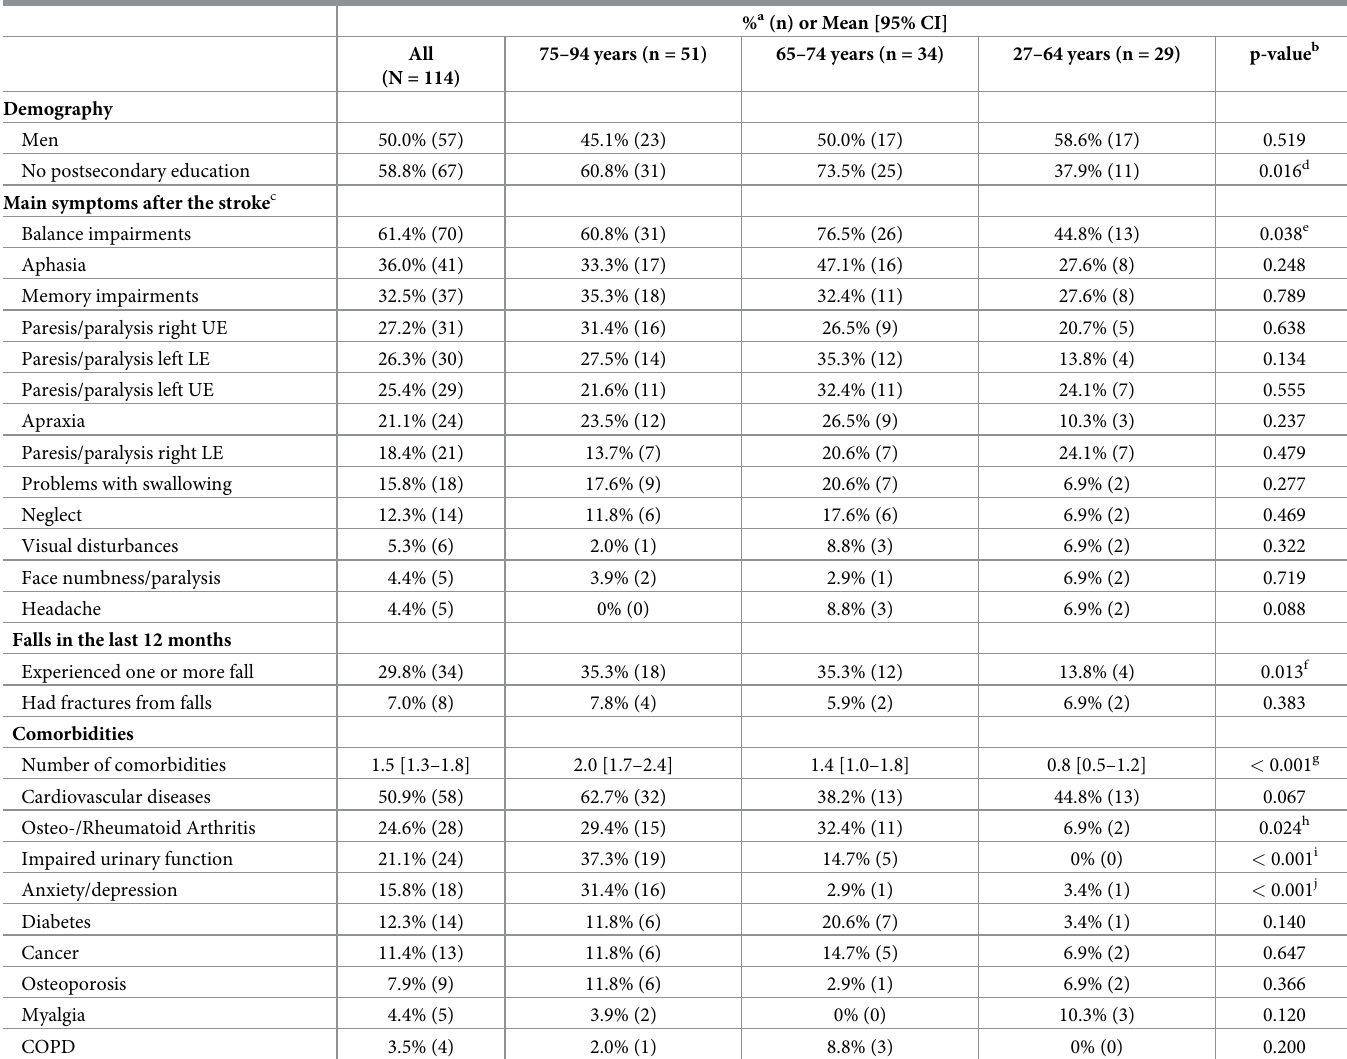
Table 1. Personal